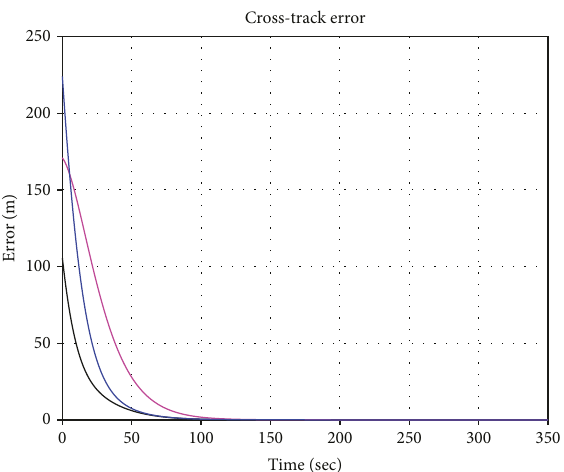
Figure 10: Cross-track errors in helical path